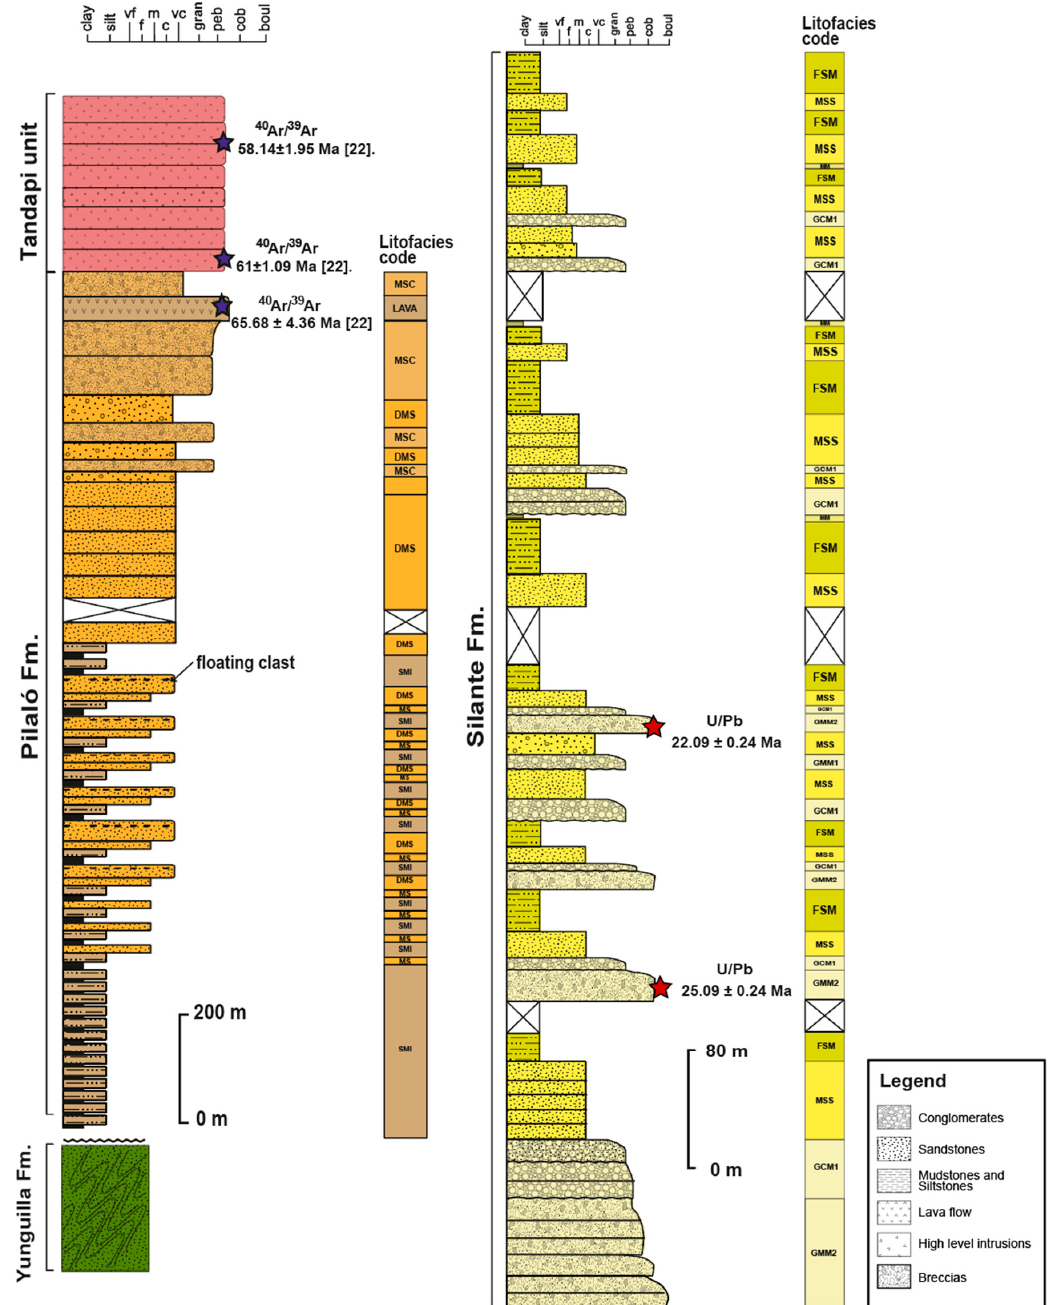
Figure 5. Composite stratigraphic column of the Nono–Tandayapa road section with lithofacies described for the Pilalo and Silante formations (lithofacies codes are discussed in text). Radiometric ages obtained by Vallejo [22] and this study are located with the proposed composite stratigraphic column of the study area.